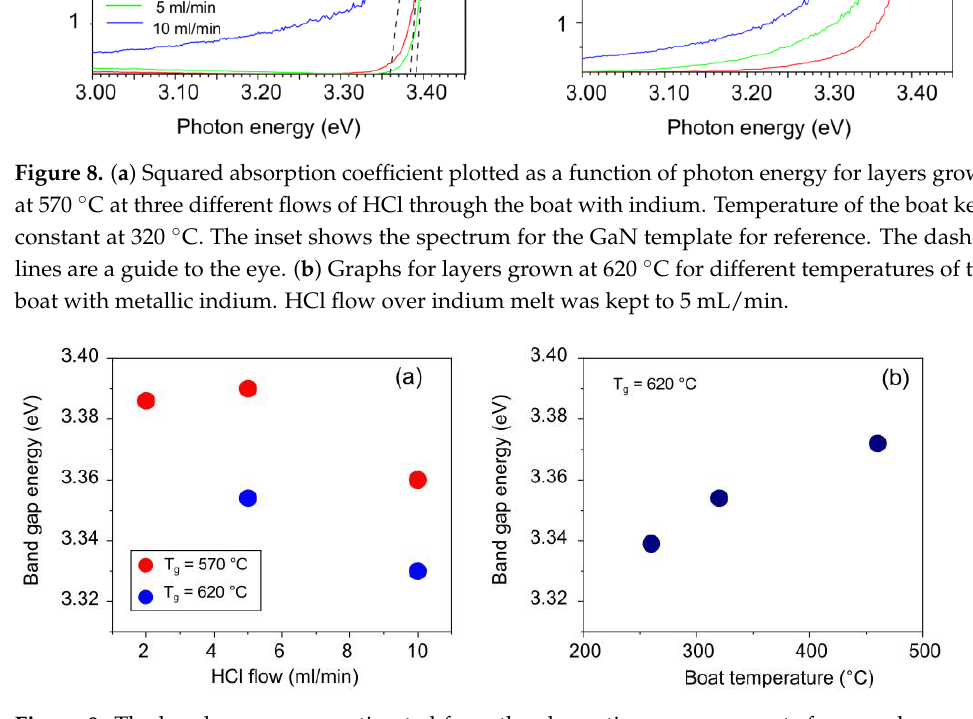
Figure 9. The band gap energy estimated from the absorption measurements for samples grown ( a ) with different HCl flows through the boat with indium and ( b ) at different temperatures of the boat with indium. Table 1. In content estimated by different techniques for layers grown with different process parameters. In Boat Temperature ( ◦